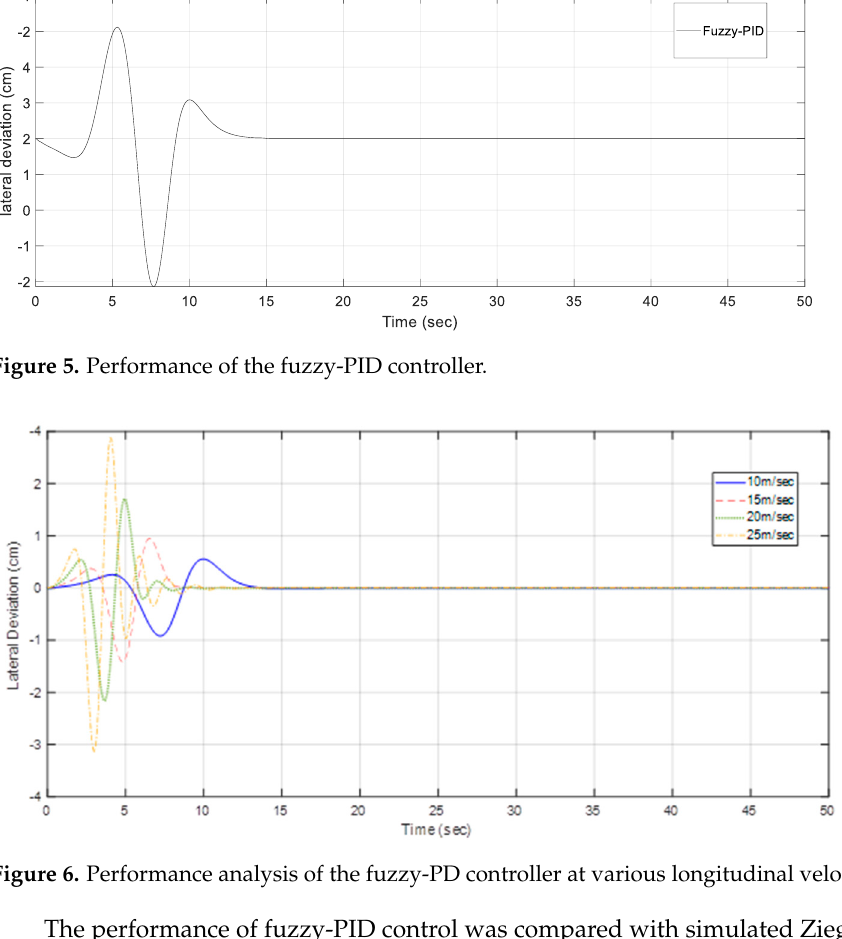
Figure 5. Performance of the fuzzy-PID controller.